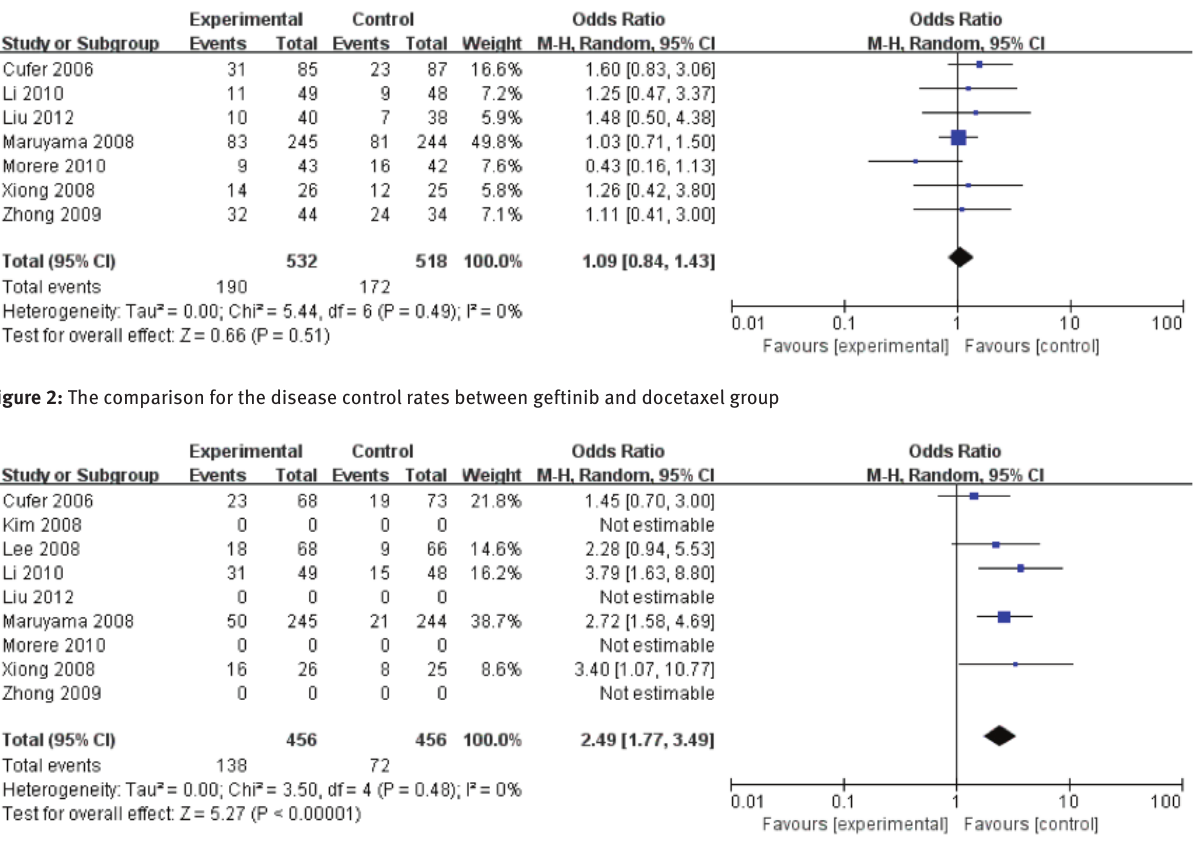
Figure 3: The comparison for the quality-of-life improvement rates between geftinib and docetaxel